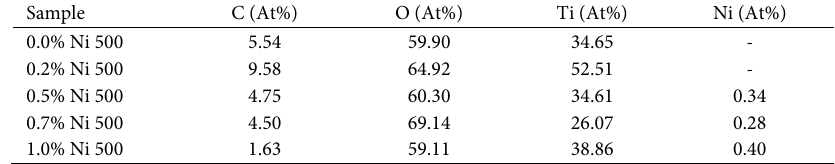
samples heated at 500 ° C (At%: atomic 2